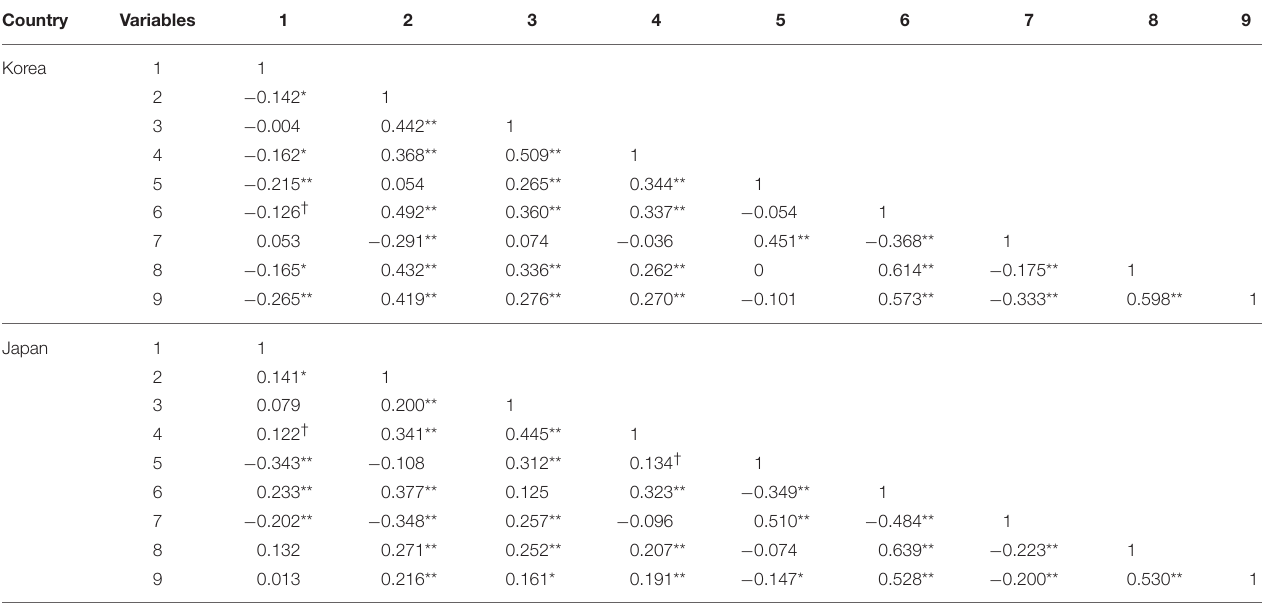
TABLE 2 | Correlations between main variables in each culture. Country